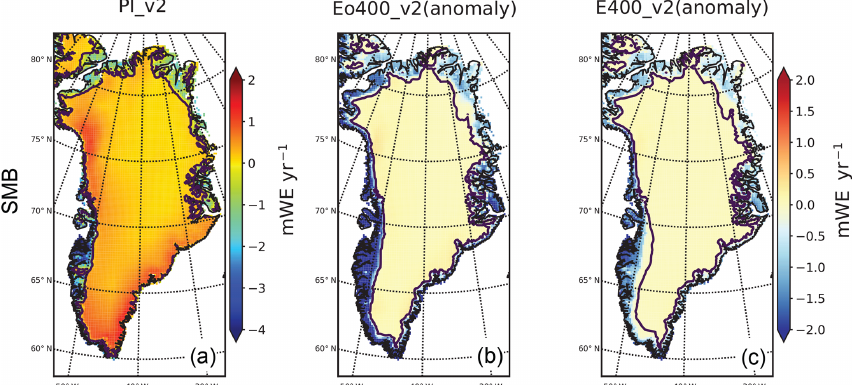
Figure 10. Mean annual surface mass balance (SMB) in Greenland in the PI control experiment (a) and the anomalies of the SMB in Eo400_v2 (b) and E400_v2 (c) experiments in comparison with the PI control (unit: mWE (water equivalent)yr − 1 ). The contour line indicates the zero